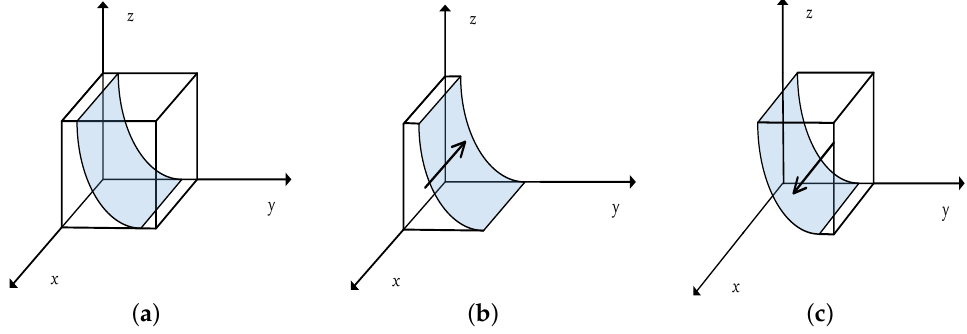
Figure 2. Replication dynamic phase diagram of crowd workers: ( a ) y = y 0 ; ( b ) y < y 0 ; ( c ) y > y 0